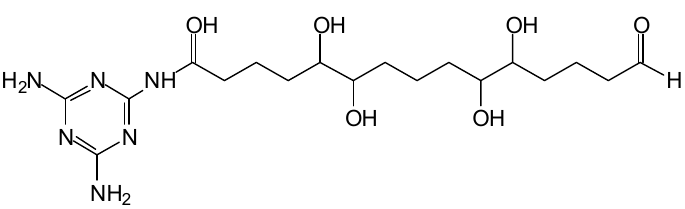
Scheme 9. Reaction of a glutaraldehyde aldol condensate on melamine.